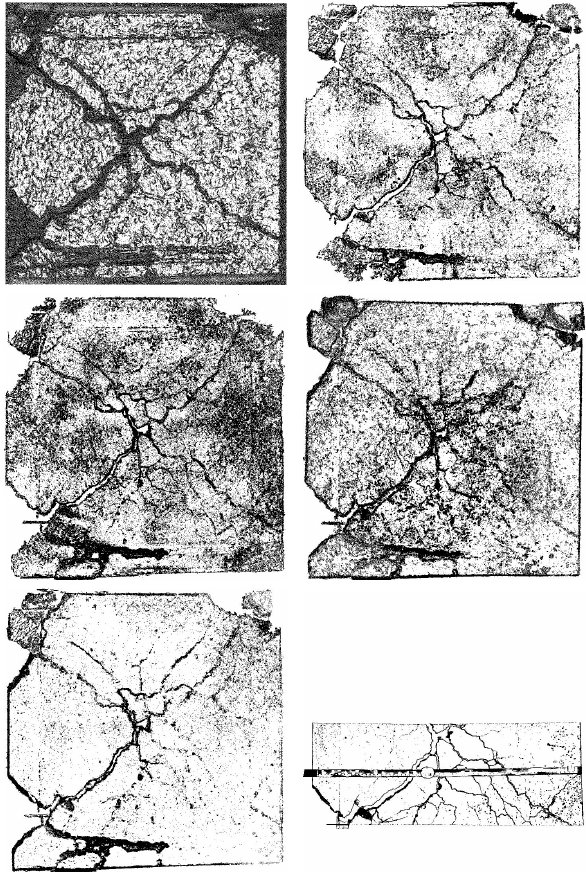
Figure 13. Point cloud with depth gradient greater than 10 percent from the different sensors line by line in the sequence: PPS-Plus, S8, Fuji, Fuji sun, G-419B, and Sick